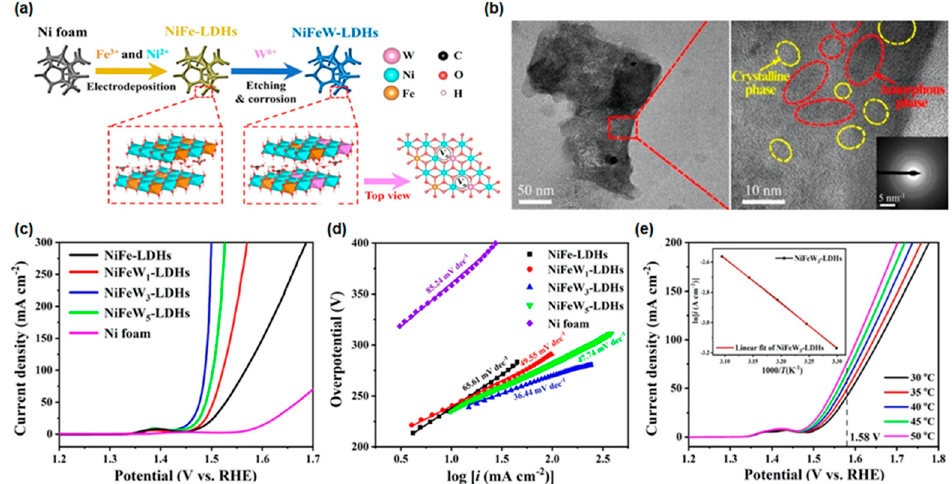
Figure 3. ( a ) Schematic diagram of a two-step synthesis process of NiFeW-LDHs electrocatalysts. ( b ) TEM images of NiFeW 3 -LDHs catalysts. ( c ) Polarization curves and ( d ) Tafel fitting curves after iR correction for the OER in alkaline medium. ( e ) Polarization curves at various temperatures and ln(current density) vs. 1/T fitting curves of NiFeW 3 -LDHs. Reprinted (adapted) from [127], copyright (2023) Elsevier